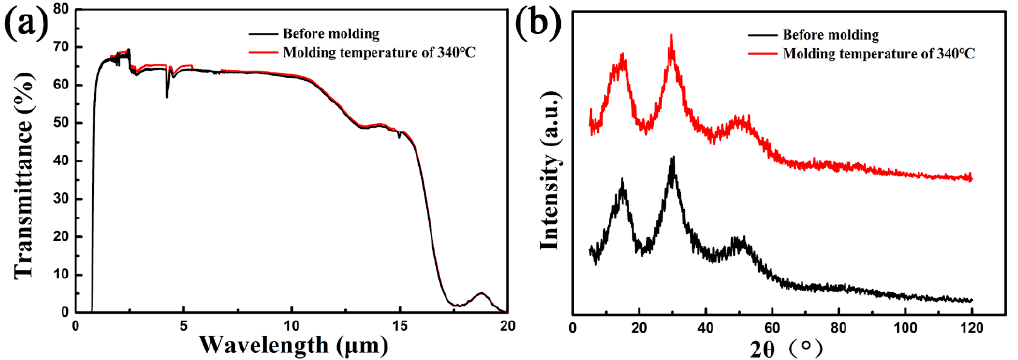
Figure 5. ( a ) Transmittance of the ChG before and after molding. ( b ) XRD patterns of the ChG before and after molding.